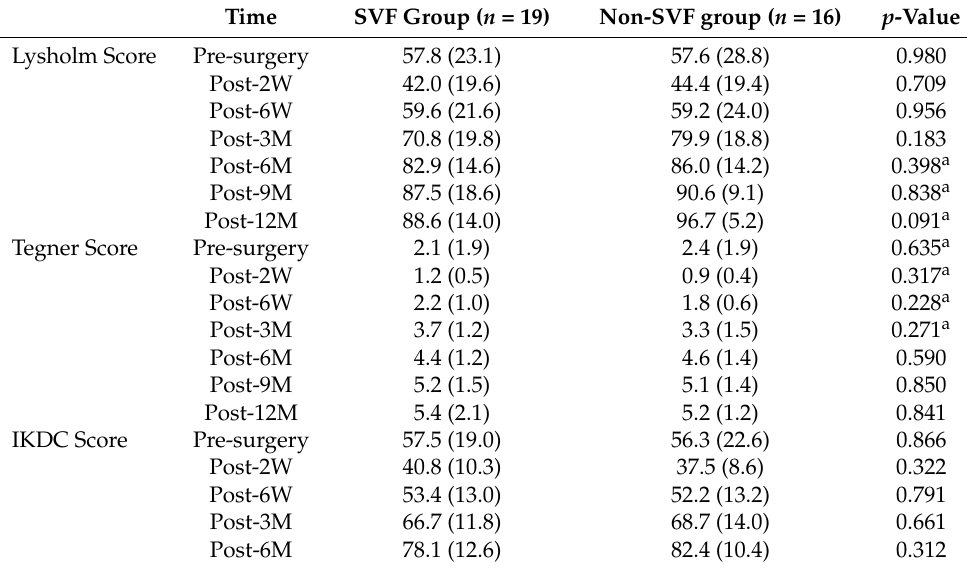
Table 1. Functional outcome scores assessed over time in the two study